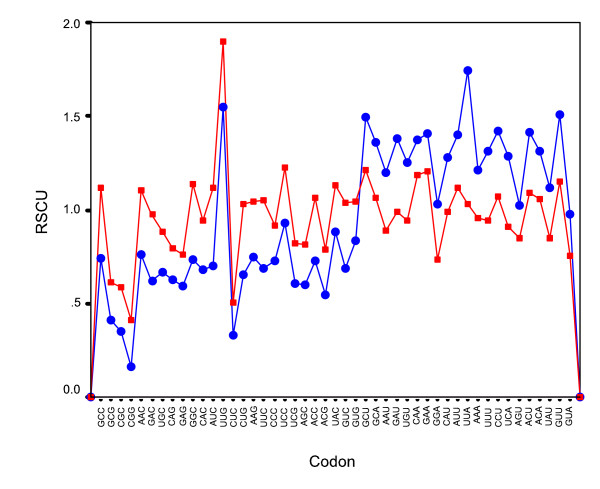
A comparision of the average RSCU values of hot ORFs with that of cold ORFs. From left to right, the first 26 codons are statistically more frequent in the hot ORFs while the last 21 triplets are used at the higher frequency in the cold ORFs (P < 0.05). The RSCU values of hot group are marked with filled red squares, while those of cold group are marked with filled blue circles.